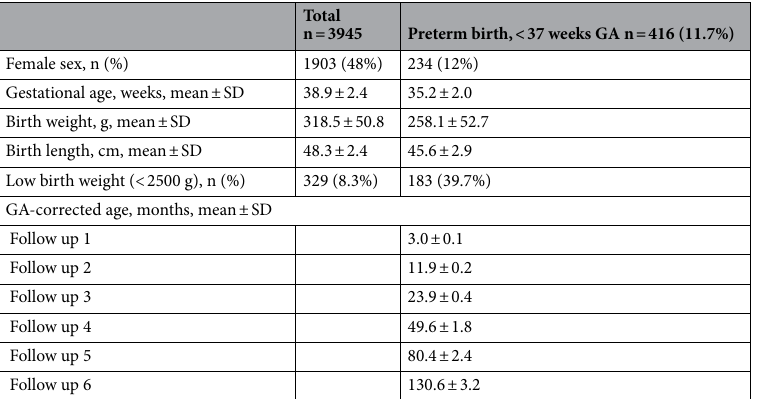
Total n = 3945 Preterm birth, < 37 weeks GA n = 416